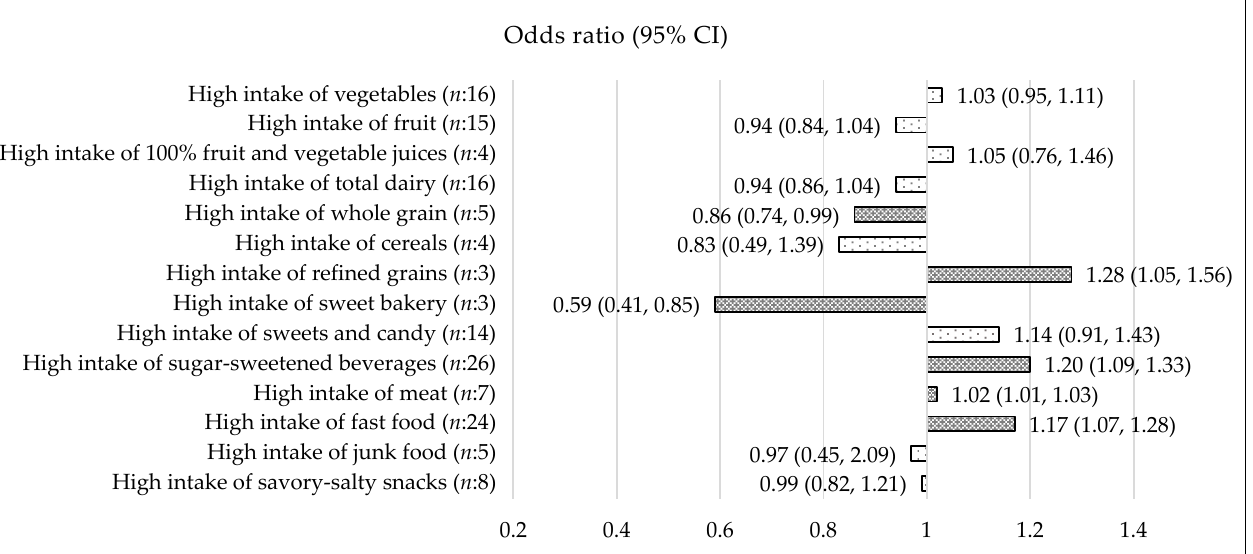
Figure 1. Study selection process.